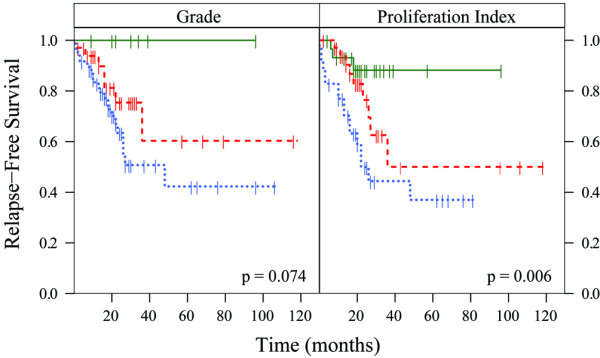
Grade and proliferation as predictors of relapse-free survival. A Cox regression model was used to determine probability of relapse over time. Kaplan-Meier curves show the time to event given different grades and levels of proliferation. The grade was scored as low (green), medium (red) or high (blue). The proliferation score was based on continuous expression data, and is shown as tertiles that correspond to low (green), medium (red), and high (blue) levels of expression. The proliferation meta-gene (log2 average of the 14 proliferation genes) showed significant value in predicting relapse, even after correcting for other clinical parameters important for survival (Table 1). Furthermore, when we include both the grade and proliferation in a model for relapse-free survival, we find that the proliferation meta-gene is the better predictor (grade, P = 0.51; proliferation index, P = 0.047).